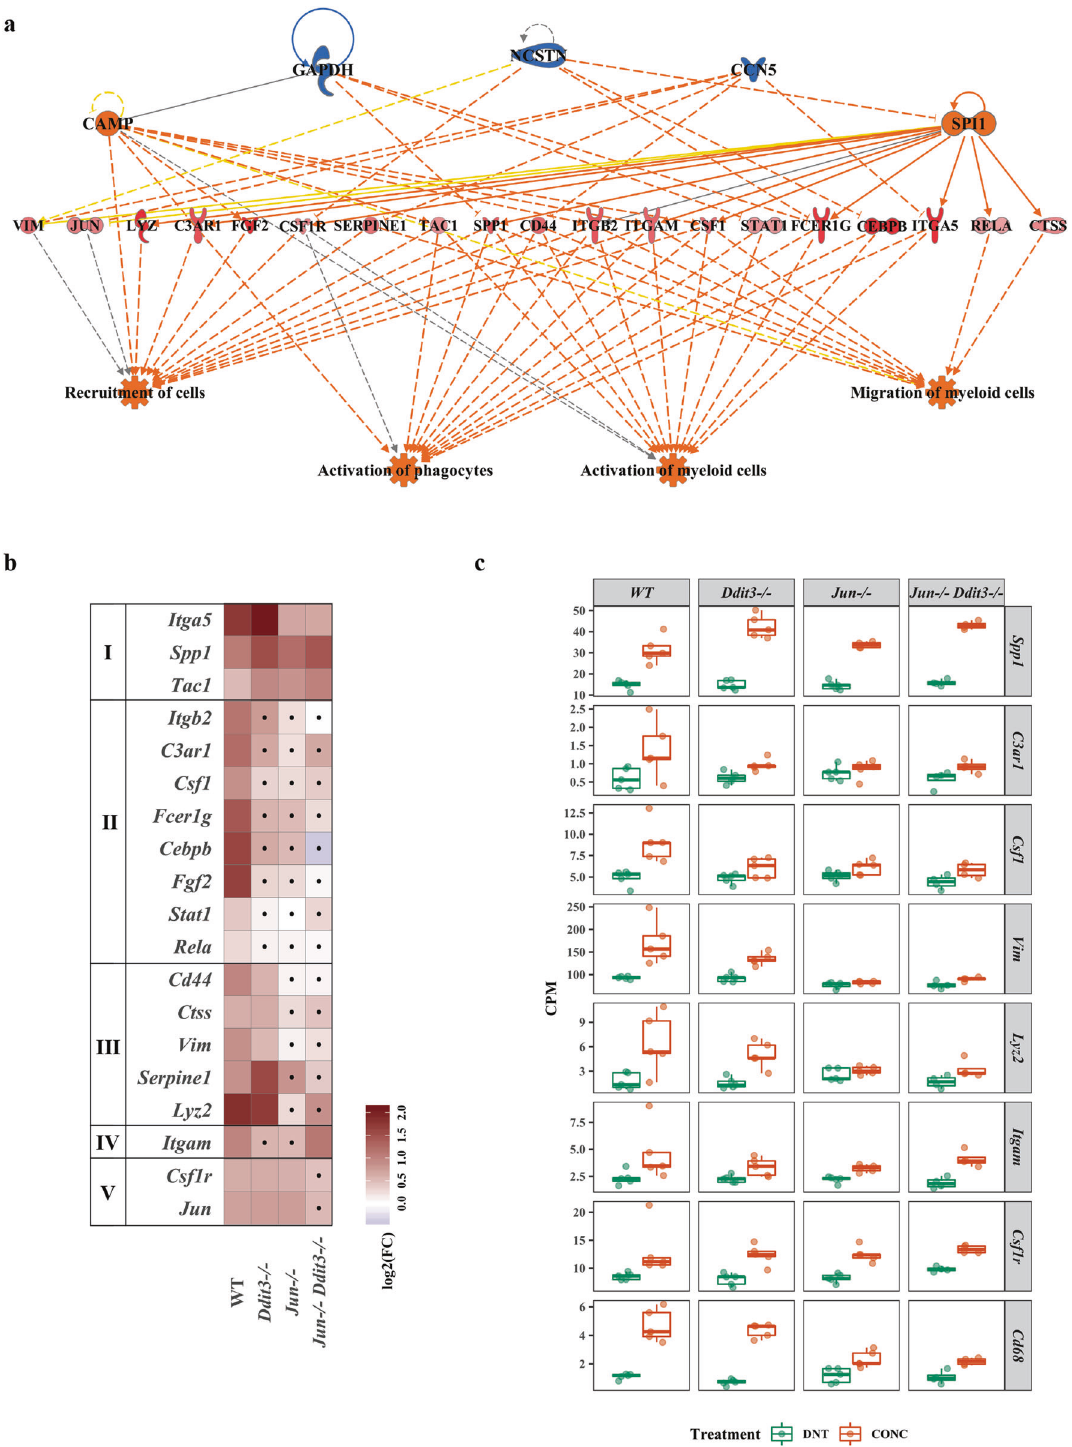
Fig. 5 Myeloid cell function is an important upstream regulator after axonal injury. The IPA regulator effect revealed the top upstream regulator network leading to myeloid cell-related functions in WT mice ( a red or blue color indicates the trend of activation or inhibition of an upstream regulator, target gene, or their predicted function, respectively). The top 5 upstream regulator networks among all genotypes were summarized in Table 1. The fold change of the target genes in the top regulator effect was reported for all genotypes ( b ). Genes were grouped by the signi fi cance level of the fold change observed in each strain (Group 1 gene: not affected by Jun , Ddit3 , and Jun/Ddit3 together; Group II gene: modulated by Jun , Ddit3 , or Jun/Ddit3 together; Group III: genes modulated by only Jun , Group IV: genes affected by either Jun or Ddit3 but not Jun/Ddit3 together; group V: genes modulated by Jun/Ddit3 together). Area marked with a dot indicates the fold change of a gene is not signi fi cant (FDR ≥ 0.05) in a given genotype group. Area without a dot indicates the fold change of a gene is signi fi cant (FDR < 0.05) in a given genotype group. Box plots demonstrate the expression levels of selected gene related to myeloid cells functions in all genotypes after CONC (orange) as compared to unmanipulated retinas ( c DNT, green).